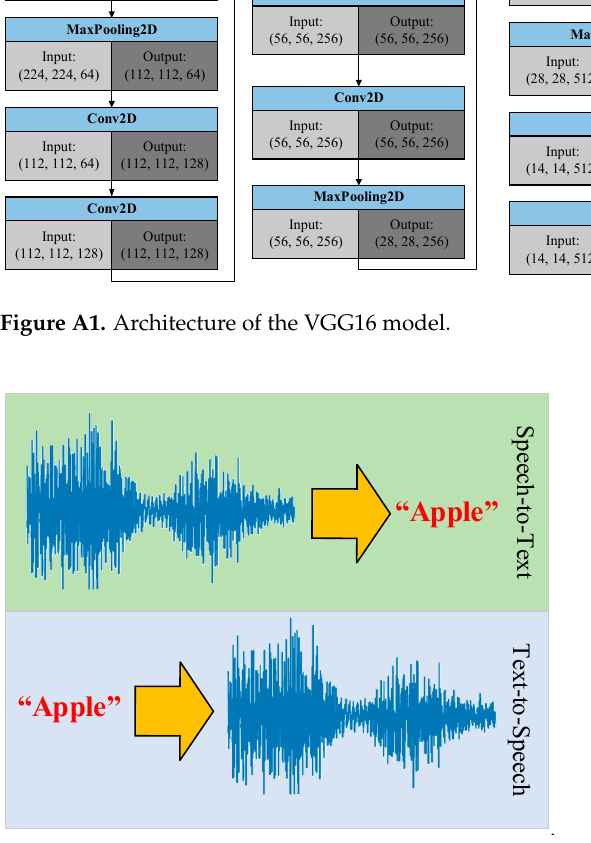
Figure A2. The process of Speech-to-Text and Text-to-Speech.